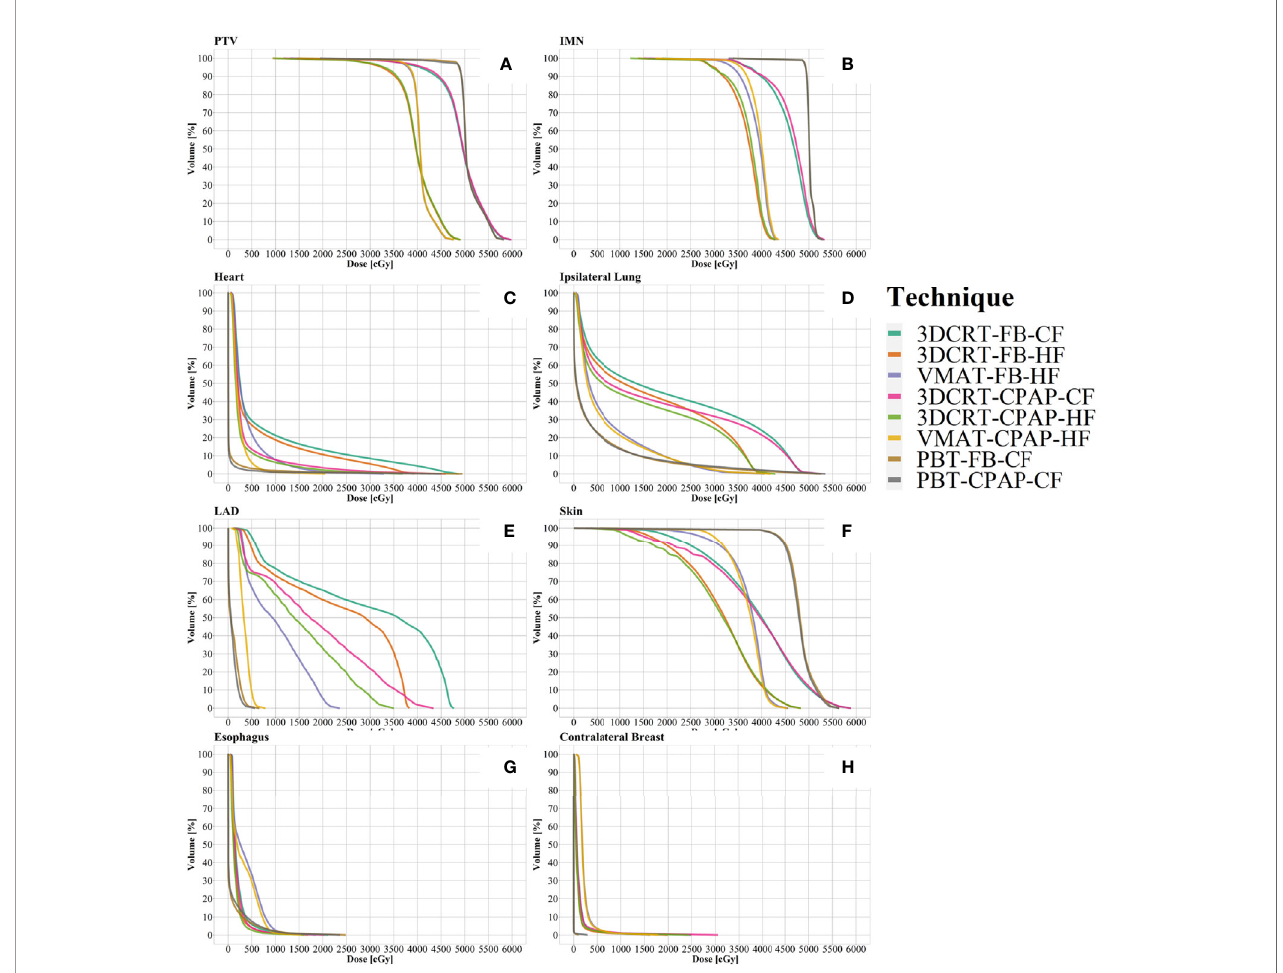
FIGURE 2 | Dose-volume histograms (DVH). (A) PTV, (B) IMN, (C) heart, (D) ipsilateral lung, (E) LAD, (F) skin, (G) esophagus, and (H) contralateral breast. Lines represent the mean DVH curve of each technique. IMN, internal mammary lymph nodes; LAD, left anterior descending artery; PTV, planning target